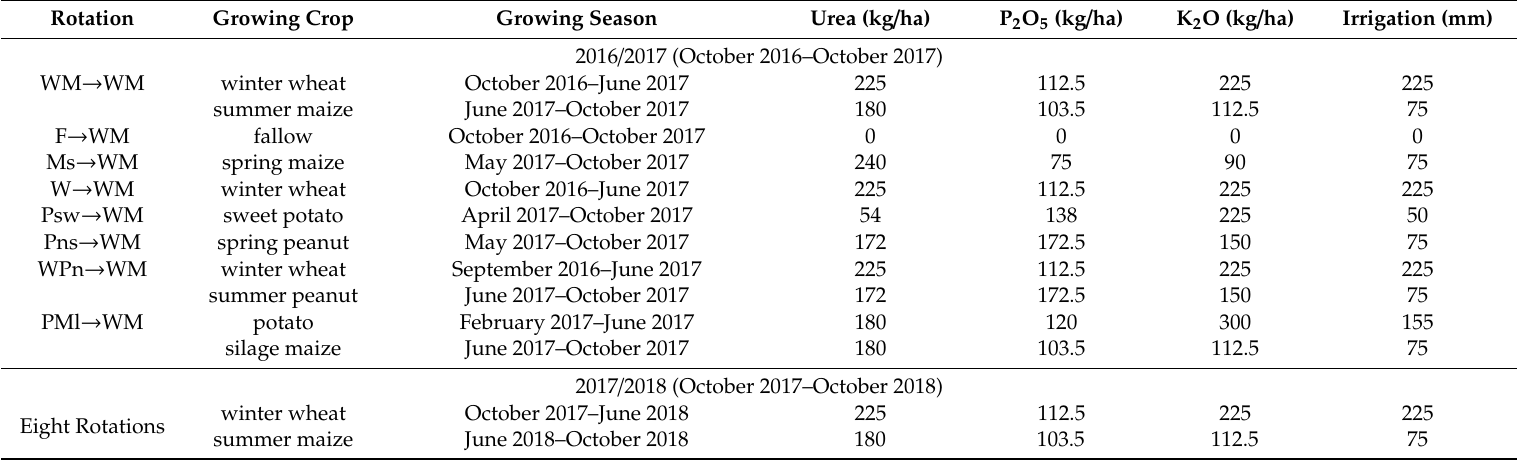
Table 1. Fertilizer and irrigation applied to each crop of eight rotations in the first two-year the